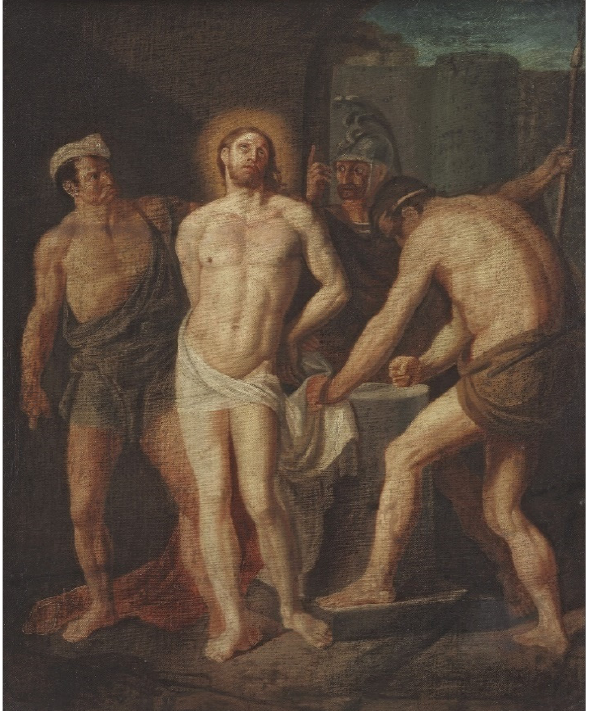
Figure 5. Aleksei Yegorov. The Flagellation of Christ , 1814. State Russian Museum, Saint Petersburg.